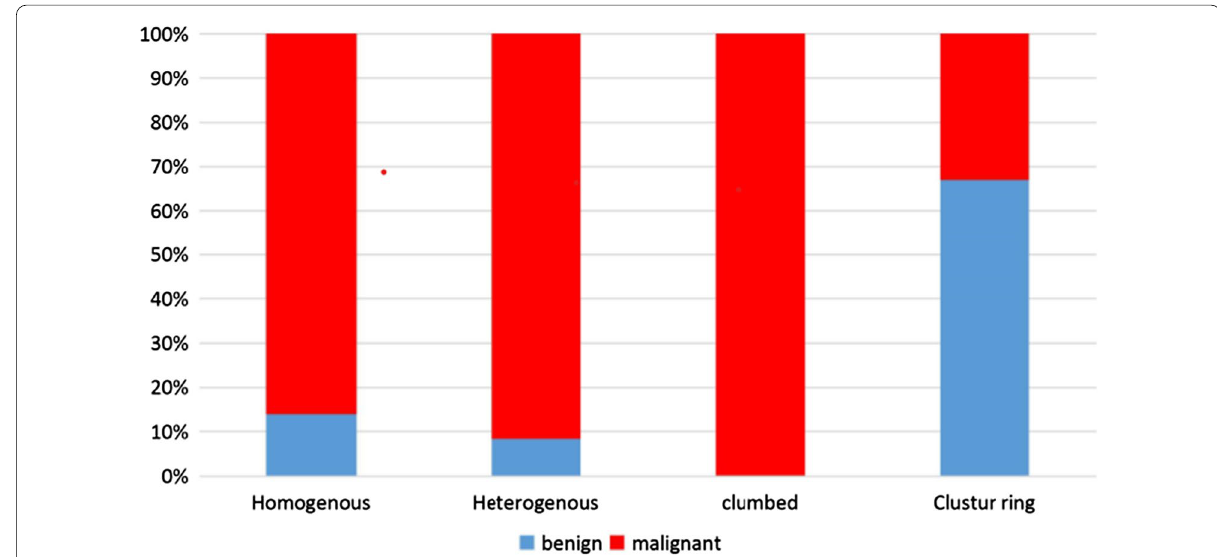
Fig. 3 correlation between non mass enhancement by CEDM and histopathological